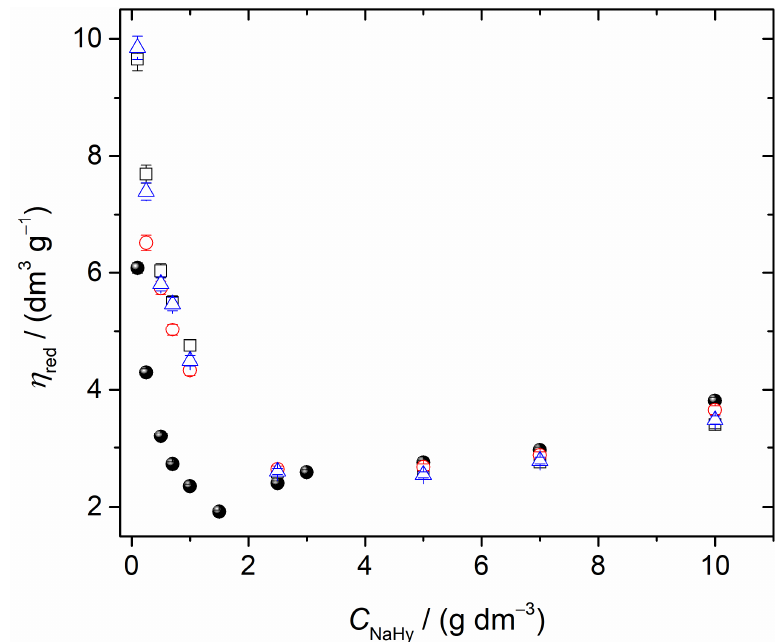
Figure 1. Dependence of reduced viscosity, η red , on the concentration of NaHy in water ( • ) and in solutions with different concentrations of β -cyclodextrin at 25 ◦ C: ( (cid:3) ) 0.001 mol dm − 3 ; (o) 0.005 mol dm − 3 ; and ( ∆ ) 0.007 mol dm − 3